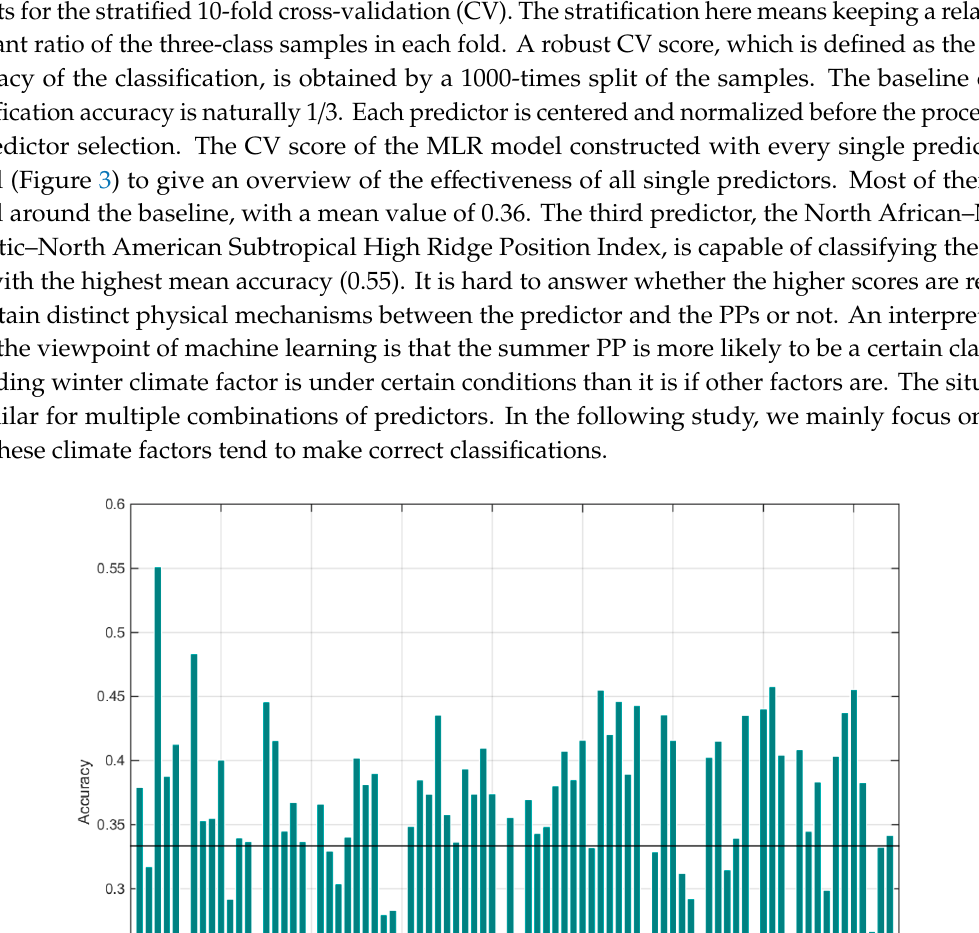
Figure 4. The repeated 10-fold CV scores ( upper panel ) and fitting scores ( lower panel ) for different C thrd s and N pre s, and predictor-selection schemes single-MLR ( left panel ), F-ratio ( middle panel ), and L1 ( right panel ). Further relationships between the CV score and different C thrd s and N pre s are investigated. On average, CV scores increase with C thrd s until about 0.8 and then decrease (Figure 5a). This implies the importance of eliminating the collinearity of predictors. The optimum threshold is a compromise between the influence of collinearity and the adequacy of the predictive information.